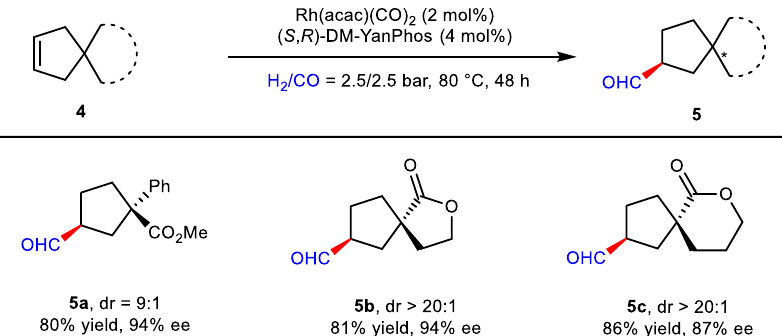
Fig. 5 Substrates for synthesis of chiral aldehydes with an all-carbon quaternary stereocenter. Reaction conditions: 4 (0.2 mmol), Rh(acac)(CO) 2 (2 mol %), L11 (4 mol%), H 2 /CO = 2.5/2.5 bar, toluene (1 mL), 80 °C, 48 h. The dr value of 5a – 5c were determined by 1 H NMR